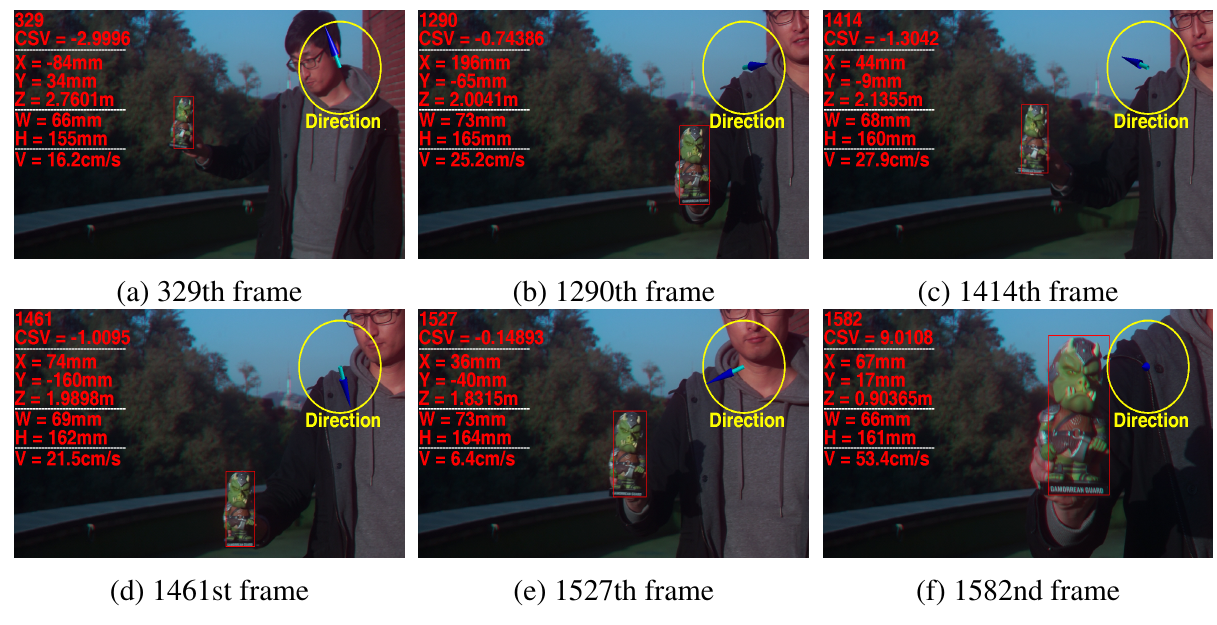
Figure 11. Estimation results of the proposed 3D states of the object ˙x method. ( a ) 329th frame; ( b ) 1290th frame; ( c ) 1414th frame; ( d ) 1461st frame; ( e ) 1527th frame; ( f ) 1582nd